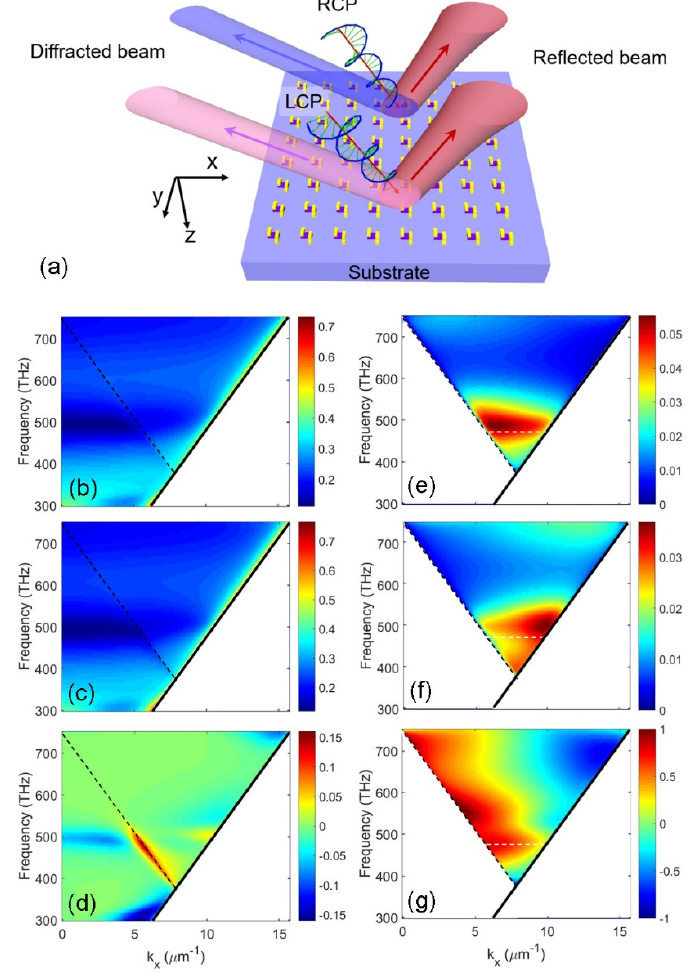
Figure 3. ( a ) The chiral plasmonic molecule array on the substrate. The reflected beams (indicates by red arrows) and the diffracted beams (indicates by blue and pink arrows) can be excited by the illuminations of LCP and RCP beams (in the xz plane). The reflection efficiencies of the chiral stereo- structure array by LCP beam in ( b ) and RCP beam in ( c ). The CD from the reflected beam in ( d ), which is calculated using the values in ( b , c ). The diffraction efficiencies with the LCP beam in ( e ) and RCP beam in ( f ), and the CD from the diffracted beam in ( g ) are shown. The black line represents a light line in free space. The black dash ed line represents the position of the Wood–Rayleigh anomaly. The white dash line in ( g ) indicates the frequency position with 474 THz ( λ = 633